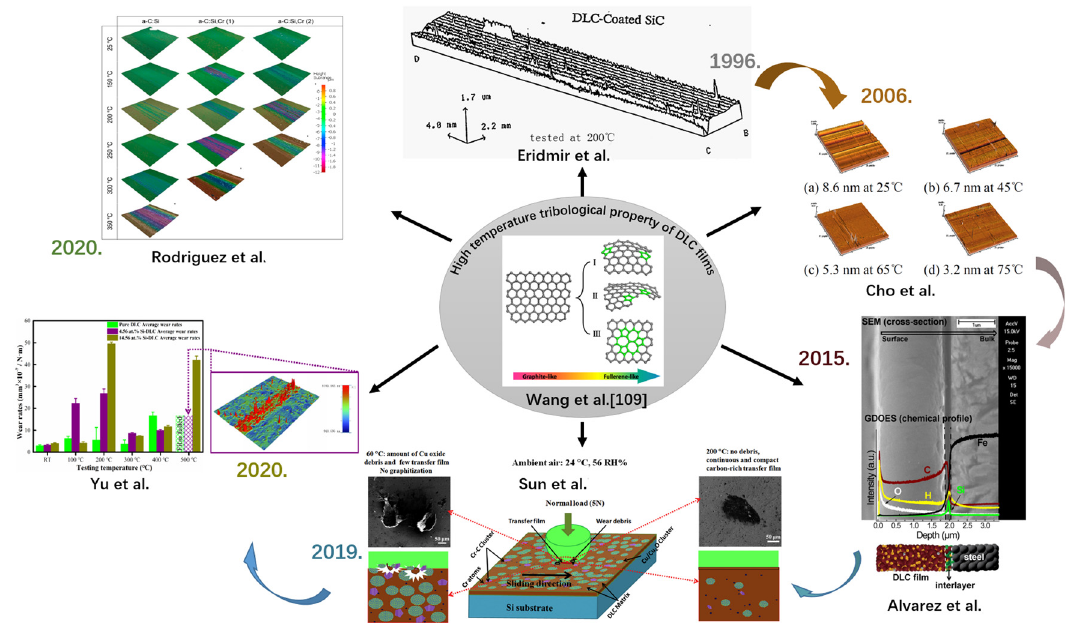
Figure 1: The reading map of DLC films at high